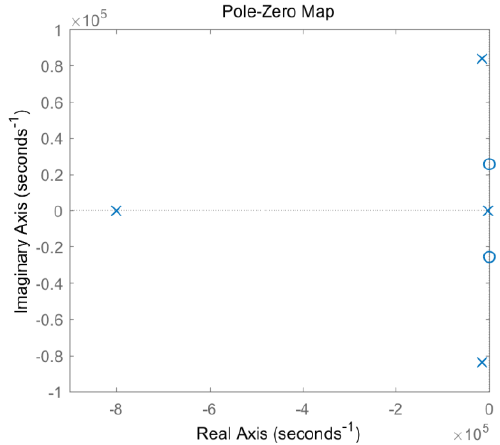
Figure 9. Zero-pole diagram of circuitry model 2.